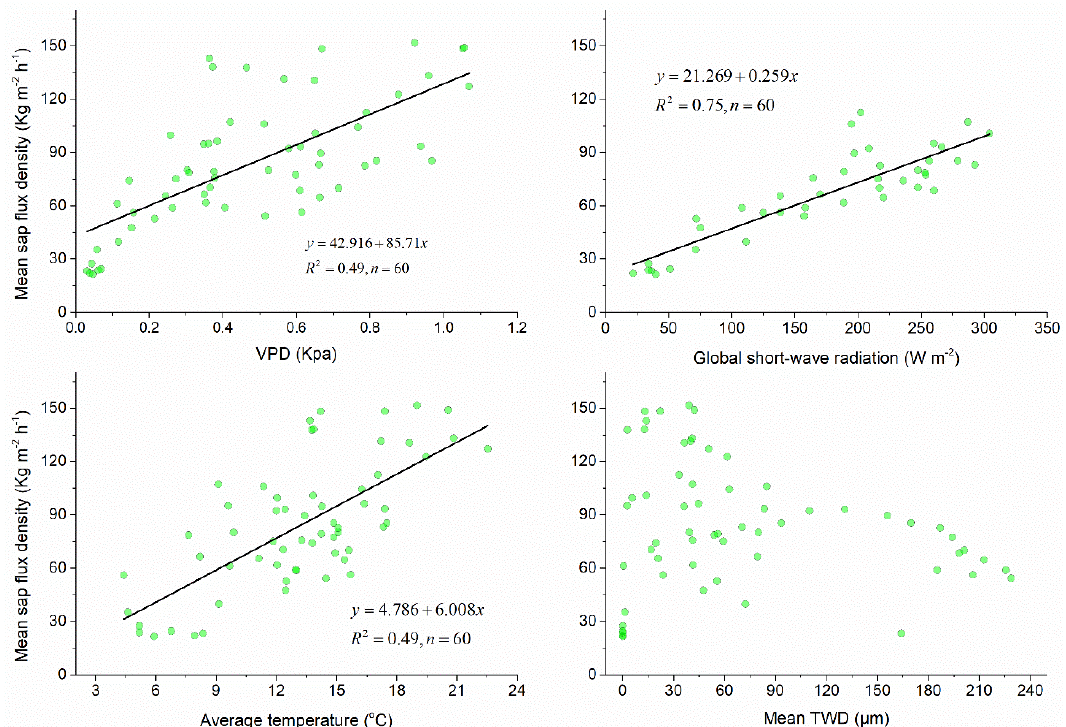
Figure 7. Relationships between sap flux density and VPD, global short-wave radiation, average air temperature, and daily TWD for the control group over the growing season.